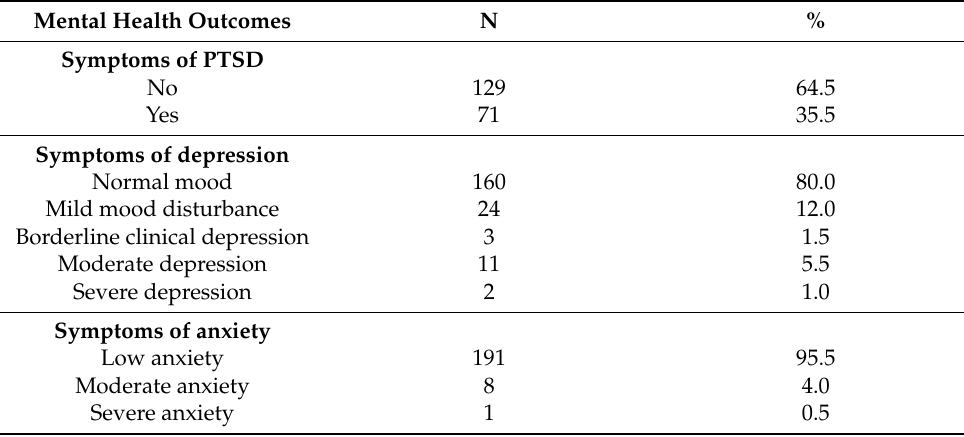
Table 3. Mental health outcomes at 1-month follow